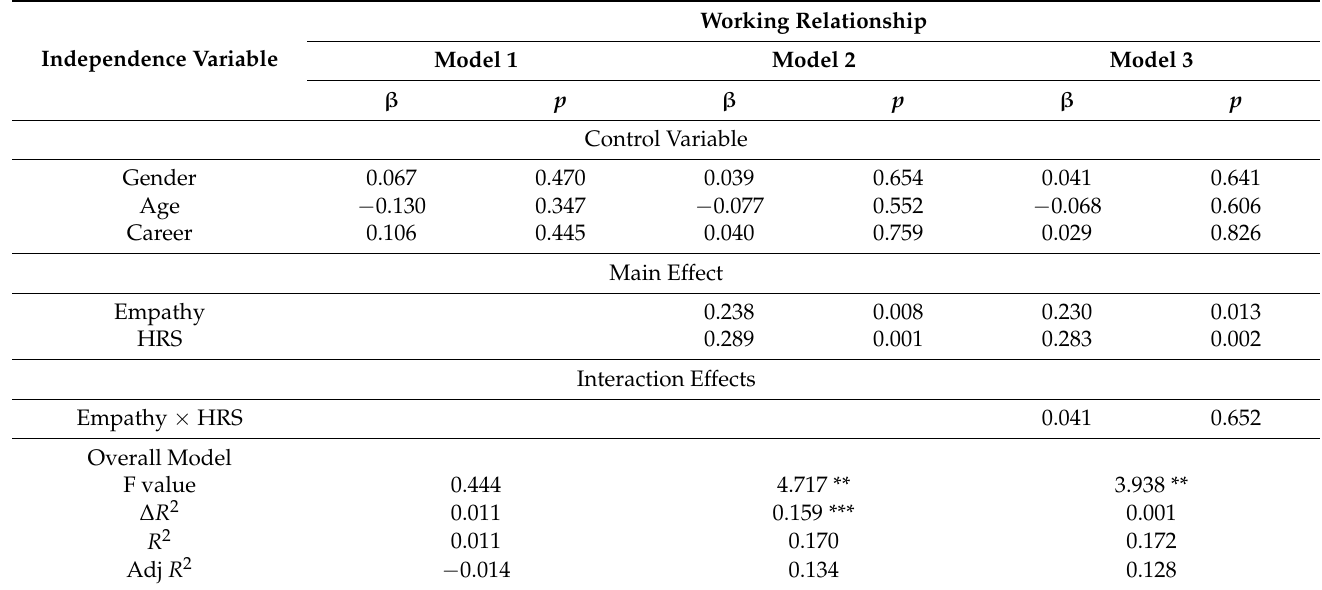
Table 5. Impact of HRS on empathy and WR with ALC